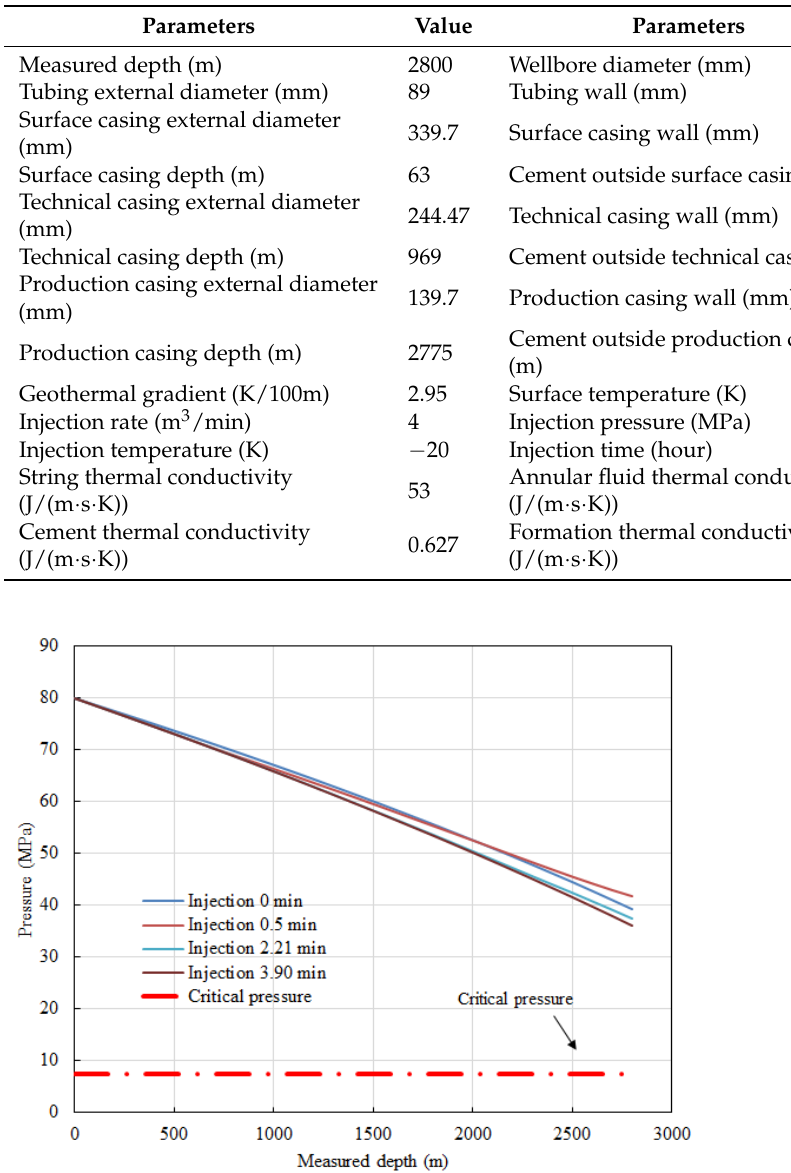
Table 2. Parameters of W-16.